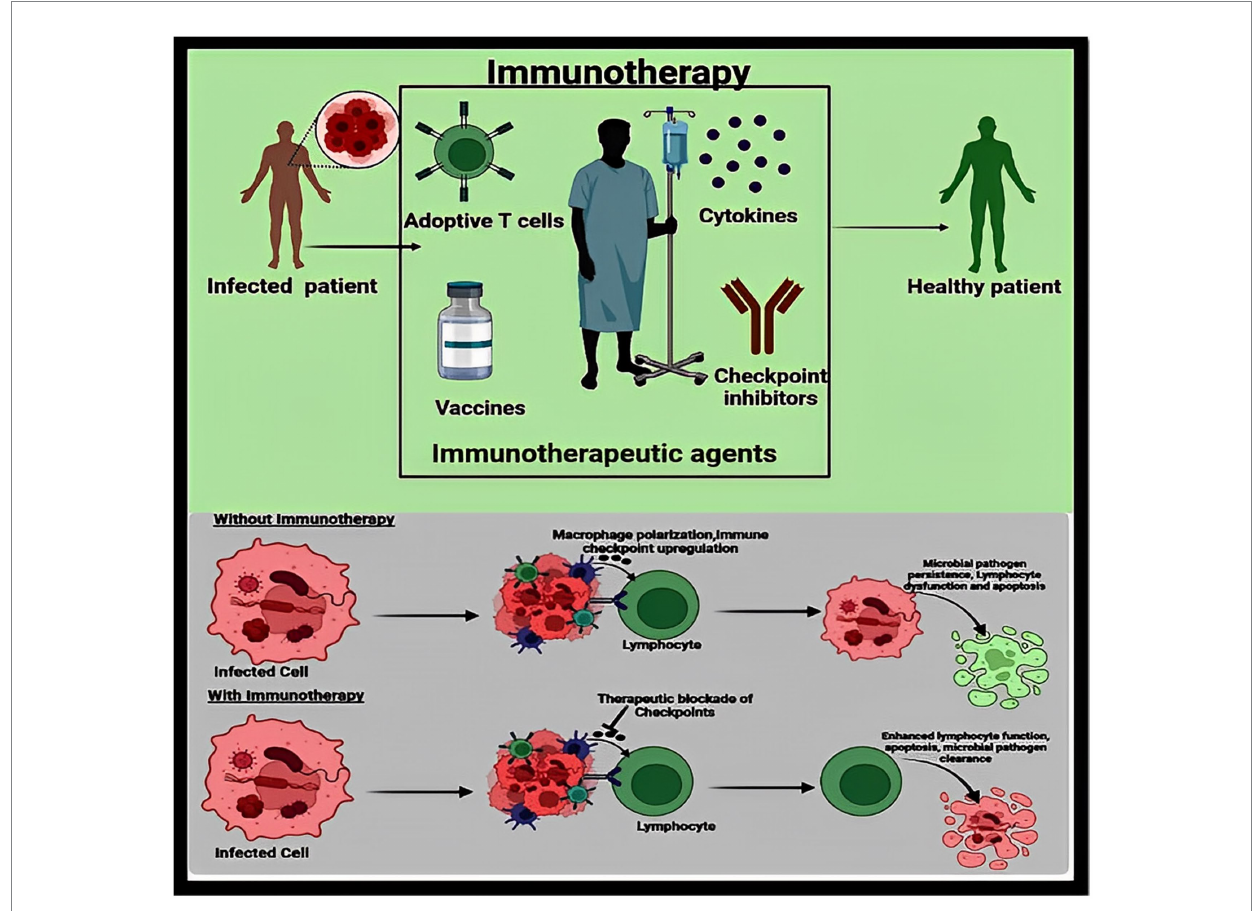
FIGURE 2 Diagrammatic illustration of the immunotherapy as a potential treatment in the case of infected